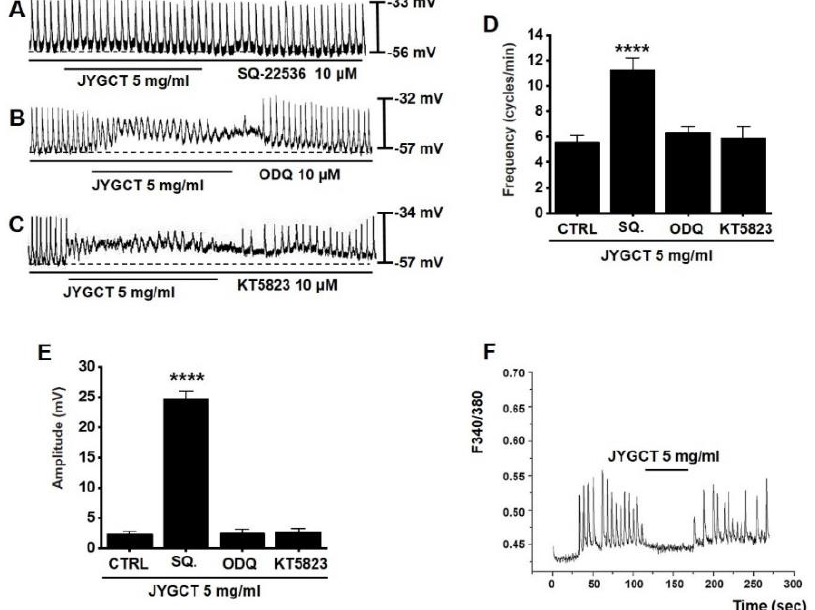
Figure 4. Effect of SQ−22536, ODQ, KT−5823 and intracellular Ca2+ flux on the pacemaker potential inhibition by JYGCT in the ICC. ( A ) Pretreatment with SQ−22536 blocked the pacemaker potential inhibition by JYGCT; ( B , C ) Pretreatment with ODQ or KT−5823 did not block the pacemaker potential inhibition by JYGCT; ( D , E ) Summary of the inhibitory frequency and amplitude effects of pretreatment with SQ−22536, ODQ, or KT−5823; ( F ) Under normal conditions, [Ca2+]i oscillations were induced and JYGCT blocked these [Ca2+]i oscillations. Bars represents the mean ± SE. **** p < 0.0001. JYGCT: Jakyakgamcho−tang; CTRL: control; SQ: SQ-22536; ODQ: 1H-[1,2,4]oxadiazole[4,3- a]quinoxalin-1-one.